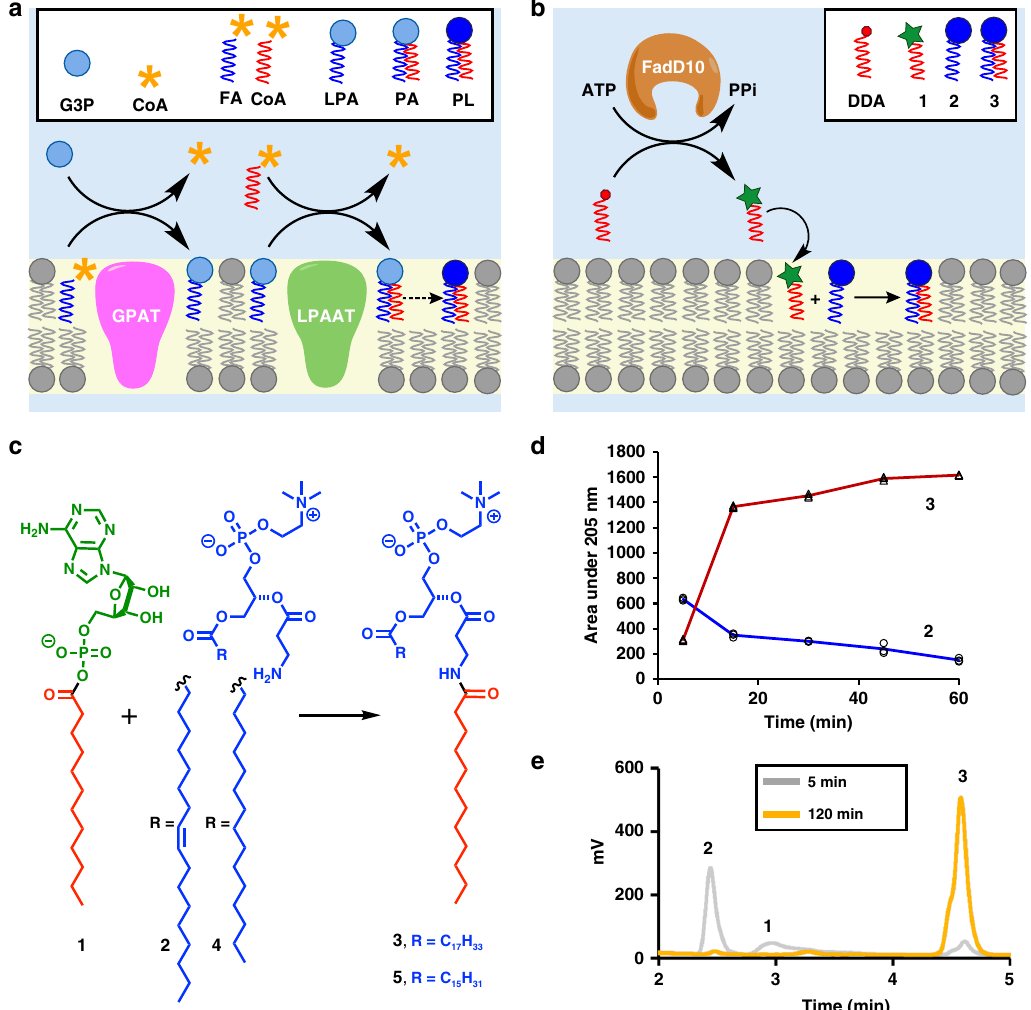
Fig. 1 De novo formation of phospholipid membranes based on adenylate chemistry. a A representative phospholipid biosynthetic pathway (Kennedy pathway), which involves multiple membrane-bound enzyme-catalyzed steps, substrates and cofactors [GPAT, glycerol-3-phosphate acyl transferase; LPAAT, lysophosphatidic acid acyl transferase; G3P, glycerol 3-phosphate; CoA, coenzyme A; FACoA, fatty acyl coenzyme A; LPA, lysophosphatidic acid; PA, phosphatidic acid; PL, phospholipid]. b The proposed synthetic pathway of phospholipids, which involves a single soluble enzyme FadD10 and reactive lipid precursors [DDA, dodecanoic acid]. c De novo synthesis of phospholipids ( 3 or 5 ) by chemoselective reaction of the model FAA dodecanoyl-AMP ( 1 ) and amine-functionalized lysolipids ( 2 or 4 ). d Kinetics of phospholipid 3 (open black triangles, red line) formation by the reaction of FAA 1 with lysolipid 2 (open black circles, blue line). Integrated HPLC peak areas (205 nm) from three experiments were used to monitor the progress of the reaction. e HPLC/ ELSD traces monitoring the selective formation of phospholipid 3 by reaction of FAA 1 and lysolipid 2 in the presence of 50 mM